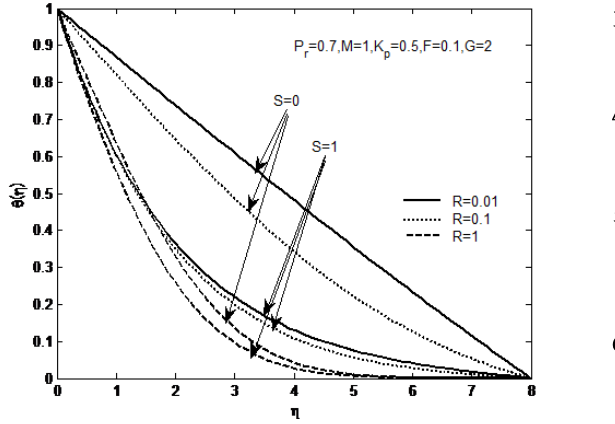
ter S ( S = 0) from the energy equation. Thermal radiation emitted by a hot body depends not only on its temperature but also on the material of the body, its shape and the na- ture of its surface. The flow characteristics at the boundary surface are vital in determining the flow stability and hence calcula- tion of skin friction, wall couple stress and Nusselt num- ber are essential. The numerical values of aforesaid pa- rameters have been shown in Table 1 for different perti- nent parameters. It can appear that the skin friction and rate of heat transfer increases with the increase of mag- netic parameter while the reverse effect has been observed for couple stress. The inclusion of porous matrix opposes the flow and heat transfer aspect resulting in retardation in skin friction coefficient and Nusselt number, but couple stresses enhanced it. In the unsteady case, the presence of heat source parameter increases the values of f (cid:48)(cid:48) (0), g (cid:48) (0) and − θ (cid:48)